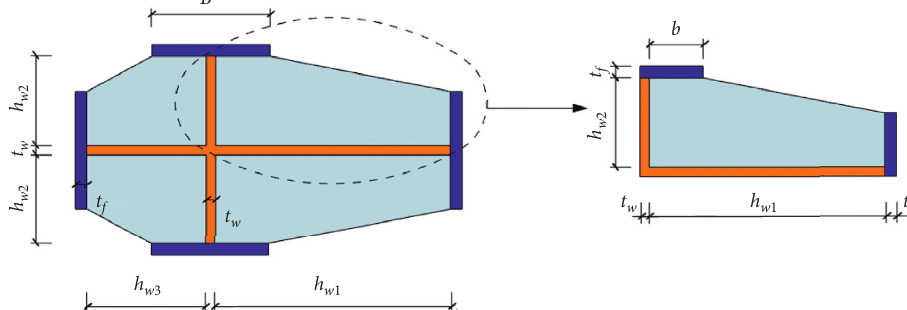
Figure 10: Cross section of the SRCC-MCS-core column.